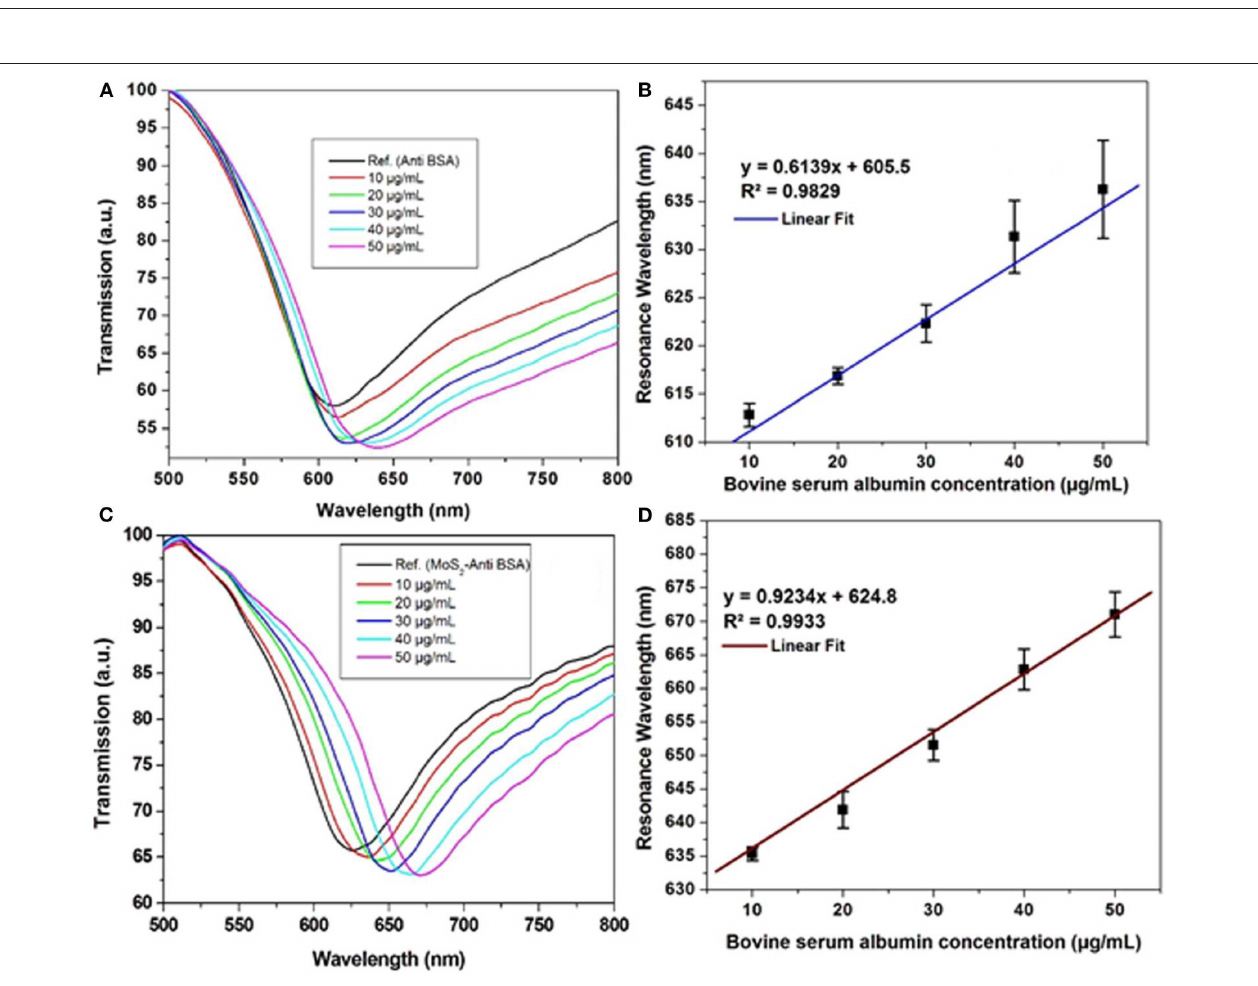
FIGURE 13 | Surface plasmon resonance signal against BSA in phosphate-buffered saline (PBS) solution of the (A) optical fiber SPR biosensor without MoS 2 and (C) developed SPR biosensor. Calibration curve of (B) Ab/gold/fiber; (D) Ab/MoS 2 /gold/fiber against varying concentration of BSA in PBS solution. Figures (A–D) were reproduced from Kaushik et al. (2019a) with permission from the Springer Nature.